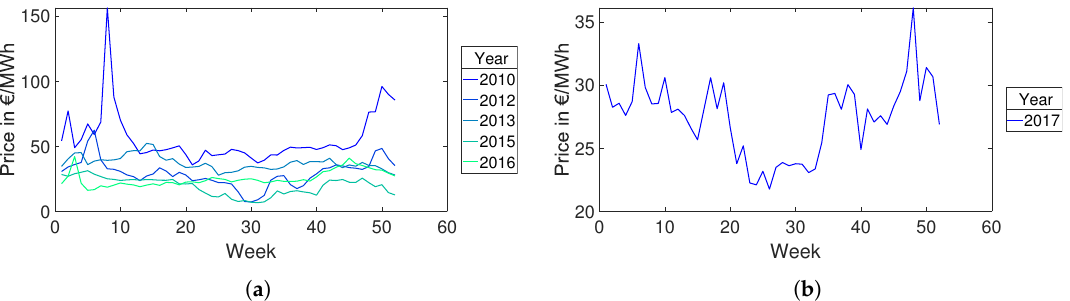
Figure 13. Weekly historical Norwegian power market prices. ( a ) Years 2010, 2012, 2013, 2015 and 2016; ( b ) Year